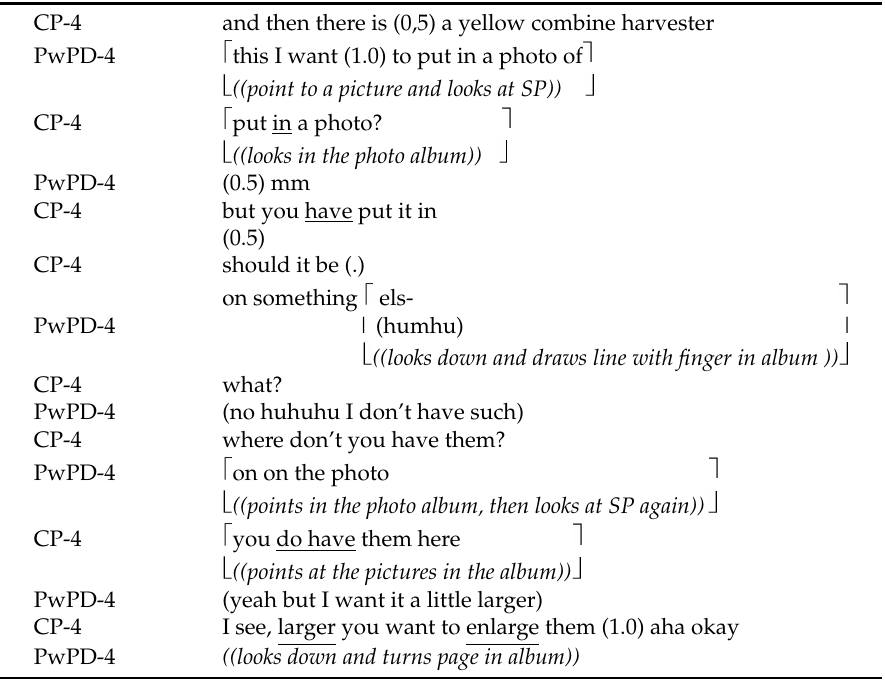
Figure 4. Word retrieval problem, prolonged repair